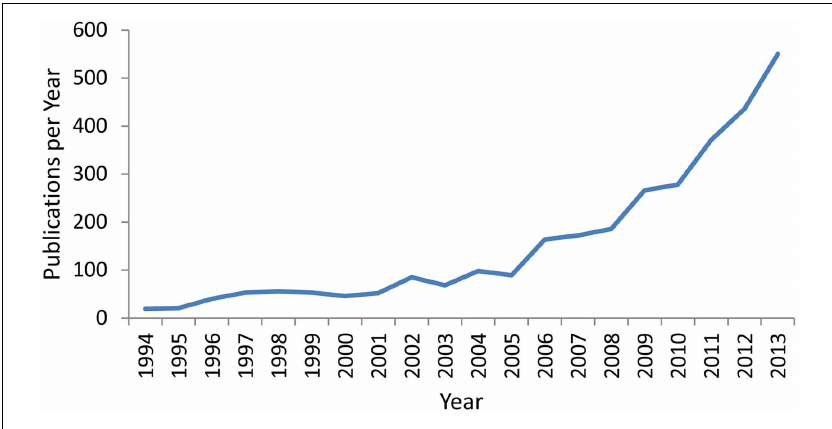
FIGURE 1 | Number of publications per year over the last 2 decades containing the terms “Cognitive Training,” “Cognitive Remediation,” or “Cognitive Rehabilitation” in the title, abstract, or key-words. Data was extracted from the Scopus Database on